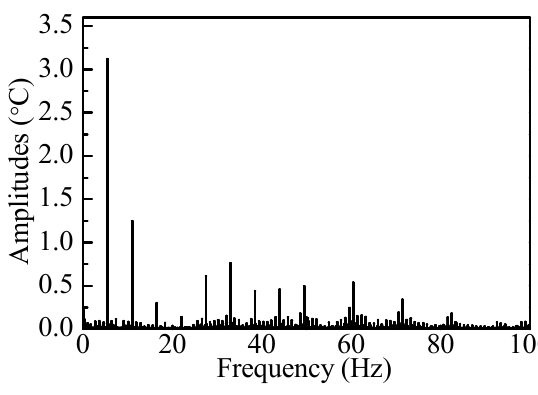
Figure 27. Frequency spectrum of original temperature